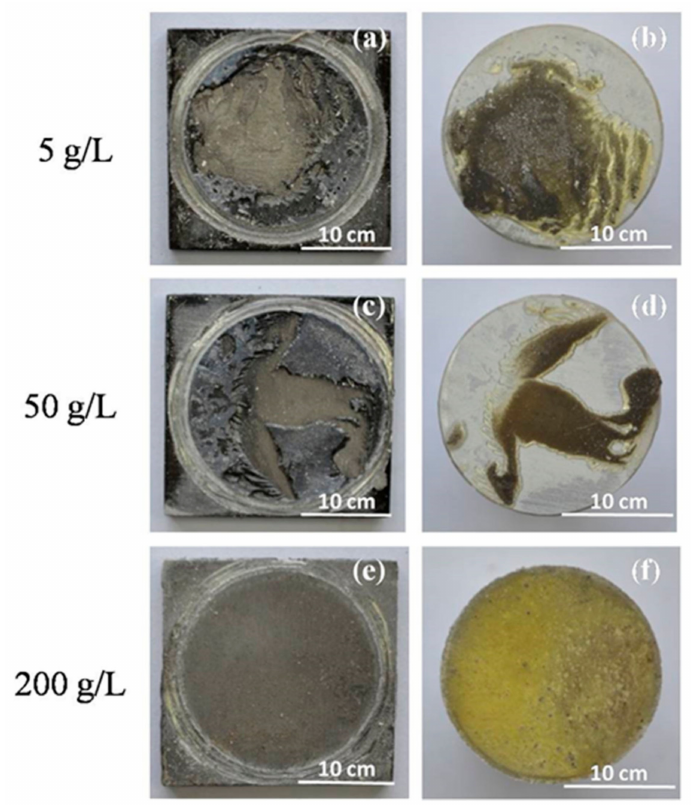
Figure 7. The morphology after the adhesion strength measurement test with the rust converter application: ( a , c , e ) the failure substrate; ( b , d , f ) the relative test